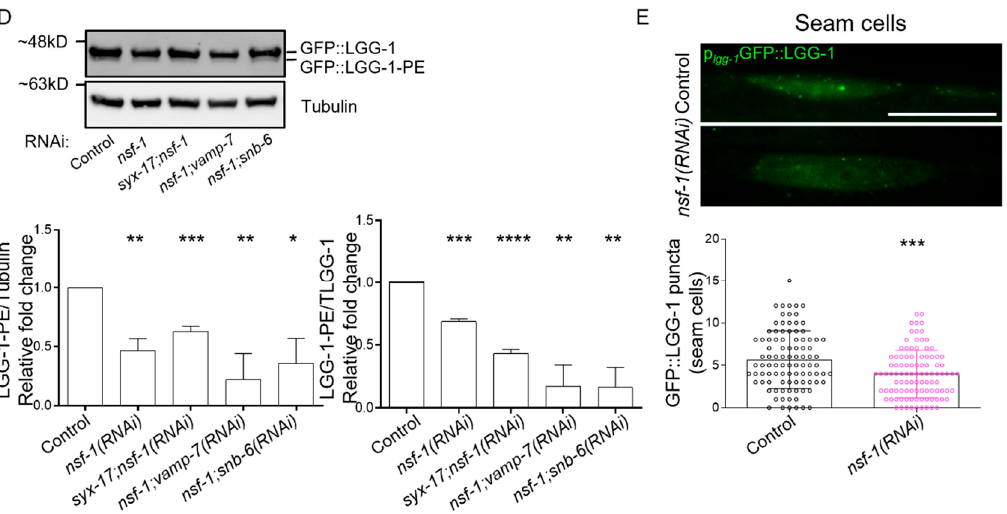
Figure 4. mitoSNARE depletion blocks basal autophagic flux in an NSF-1-dependent manner. ( A ) Immunoblot analysis of total GFP::LGG-1 and GFP::LGG-1-PE protein levels of adult day 1 animals fed with the indicated dsRNA expressing bacteria (upper panel) and the respective quantification of the normalized protein levels (lower panels). n = 2 biologically independent experiments (* p < 0.05, ** p < 0.01, unpaired two-tailed t -test). ( B ) Quantification of SQST-1::GFP positive puncta in the head region of adult day 1 animals fed with the depicted dsRNA expressing bacteria. n = 2 biologically independent experiments ( n = 224, * p < 0.05, *** p < 0.001, unpaired two-tailed t -test). Representative images are shown below the graph. The experiments were performed in 2 biological independent replicates with similar results. ( C ) Immunoblot analysis of total ATG-4.1GFP protein levels of adult day 1 animals fed with the indicated dsRNA expressing bacteria (upper panel) and the respective quantification of the normalized protein levels (lower panels). n = 2 biologically independent experiments (* p < 0.05, ** p < 0.01, unpaired two-tailed t -test). ( D ) Immunoblot analysis of total GFP::LGG-1 and GFP::LGG-1-PE protein levels of adult day 1 animals fed with the indicated dsRNA expressing bacteria (upper panel) and the respective quantification of the normalized protein levels (lower panels). n = 2 biologically independent experiments (* p < 0.05, ** p < 0.01, *** p < 0.001, **** p < 0.0001 unpaired two-tailed t -test) ( E ) Quantification of LGG-1::GFP positive puncta in the seam cells of adult day 1 animals fed with the depicted dsRNA expressing bacteria (*** p < 0.001, unpaired two-tailed t -test) (40x lens, scale bar: 20 µ